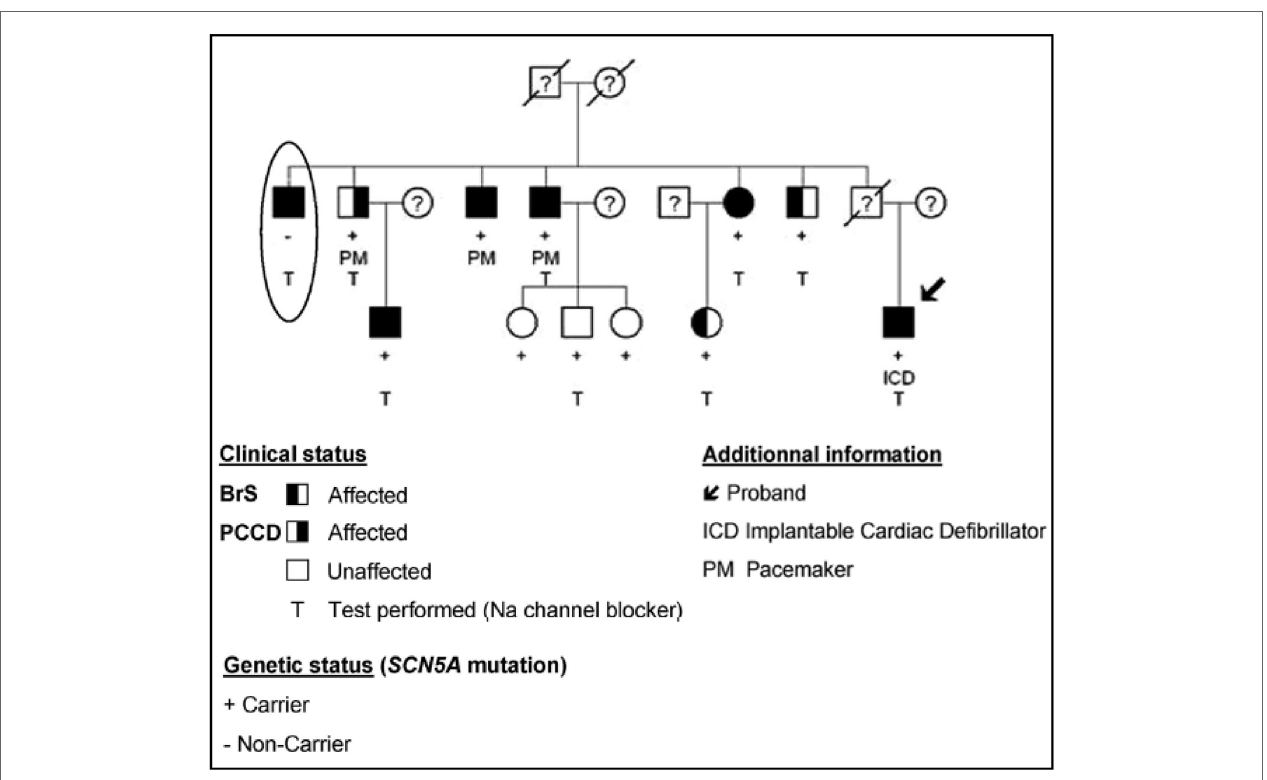
FiGURe 2 | The complex inheritance pattern of BrS . Modified from Ref. (41). Incomplete penetrance of the SCN5A mutation is illustrated by the presence of unaffected carriers of the mutation ( + ). The patient highlighted by an ellipse presents with a BrS ECG aspect, despite the absence of the familial mutation. Affected family members carrying the SCN5A mutation present with progressive cardiac conduction disease (PCCD) (right half-filled symbol), BrS (left half-filled symbol), or both diseases (full-filled symbol). PCCD consists of right bundle branch block with PR interval lengthening and led to complete AVB in three patients, in whom a pacemaker (PM) was